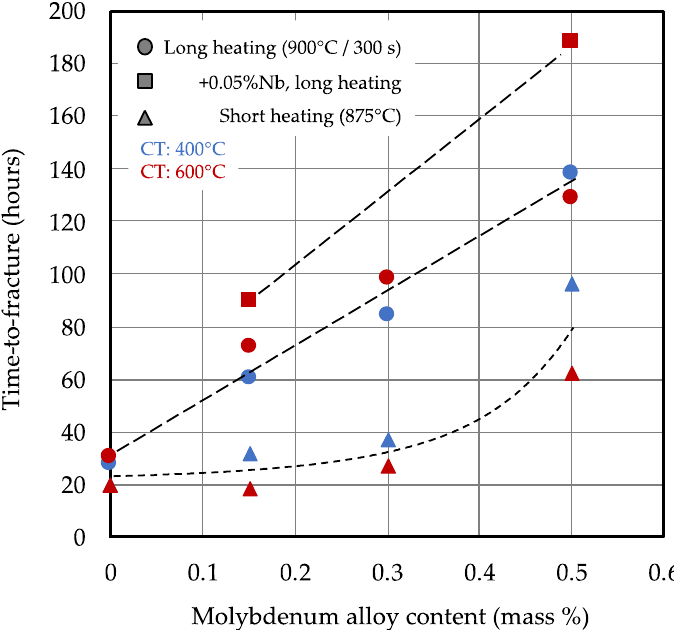
Figure 11. Delayed cracking resistance as function of the molybdenum alloy addition in 2000 MPa press hardening steel after bake hardening treatment.